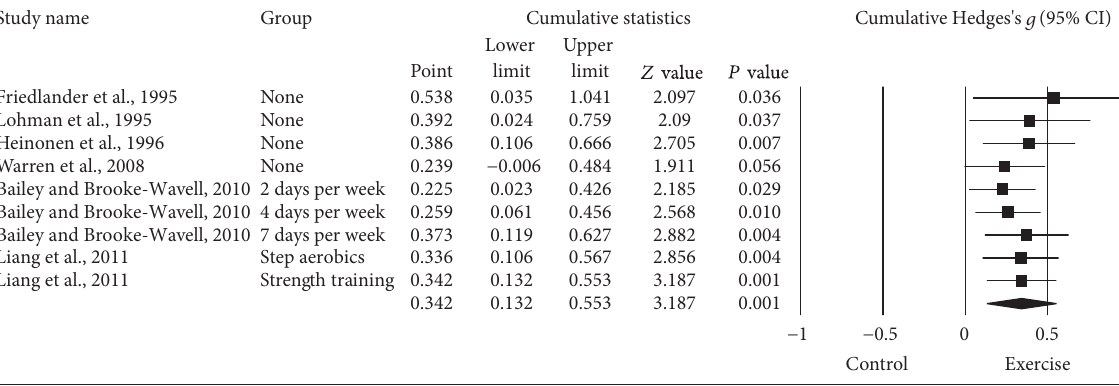
) while the le and right extremes of the diamond 𝑔𝑔